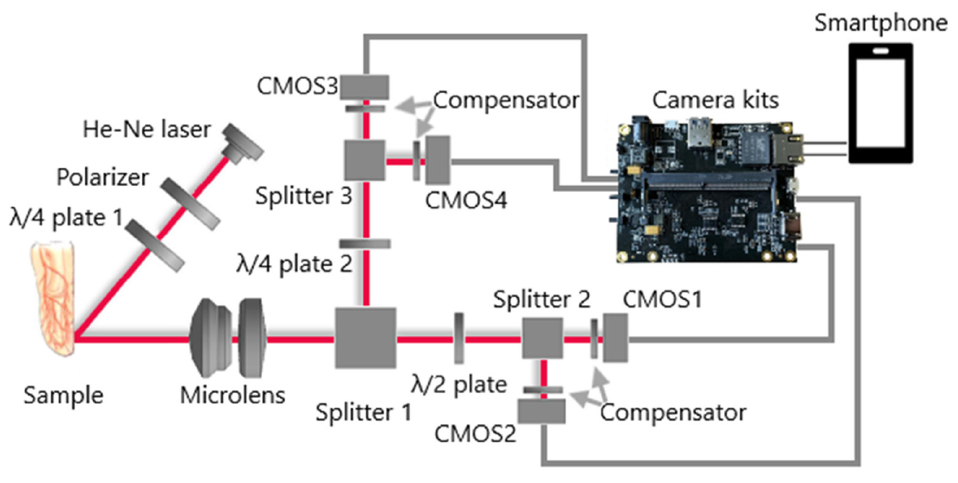
Figure 9. Structure of a polarization system based on a smartphone. A low-power laser module with a wavelength of 0.635 ± 0.005 µm and a power of